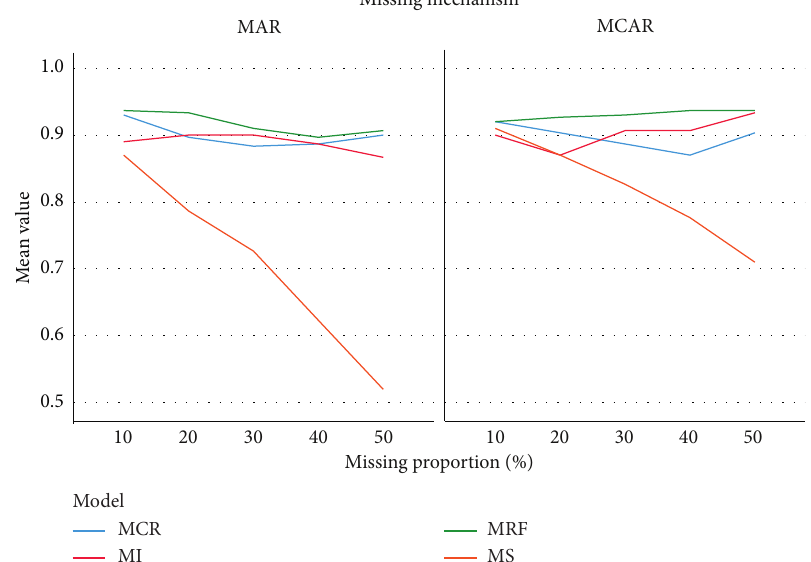
Figure 3: Comparison of the performance of imputation methods for real dataset based on the average coverage rate (CR) for the interaction effect. MAR, missing at random; MCAR, missing completely at random; MCR, multiple imputation by chained equation using classification and regression trees; MRF, multiple imputation by chained equation using random forests; MI, MICE-Interaction method; MS, MICE- Stratified